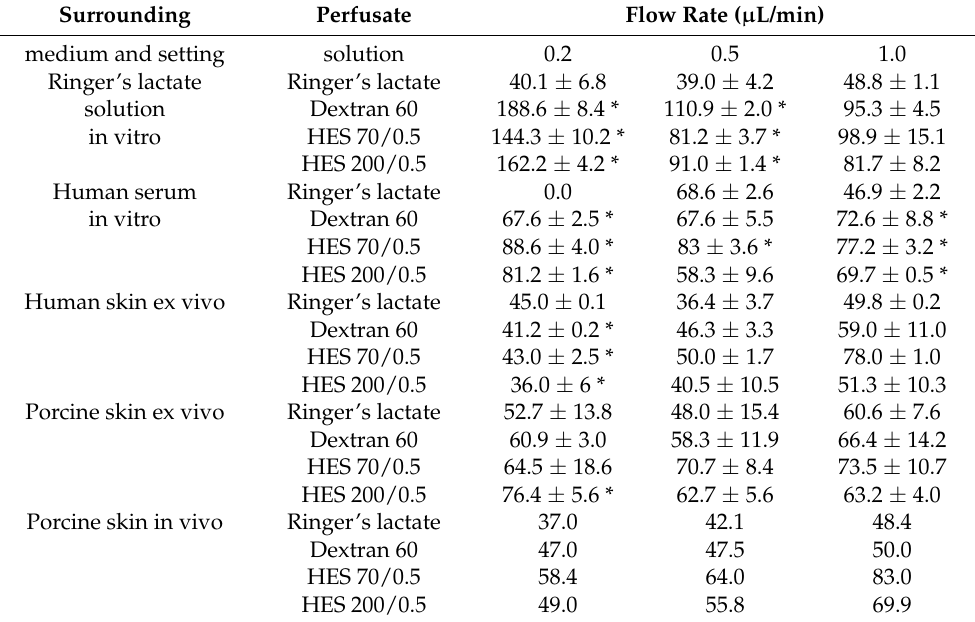
Table 1. Volume of dialysates ( µ L) recovered ( n = 3 with standard deviation, in vivo pooled data from two